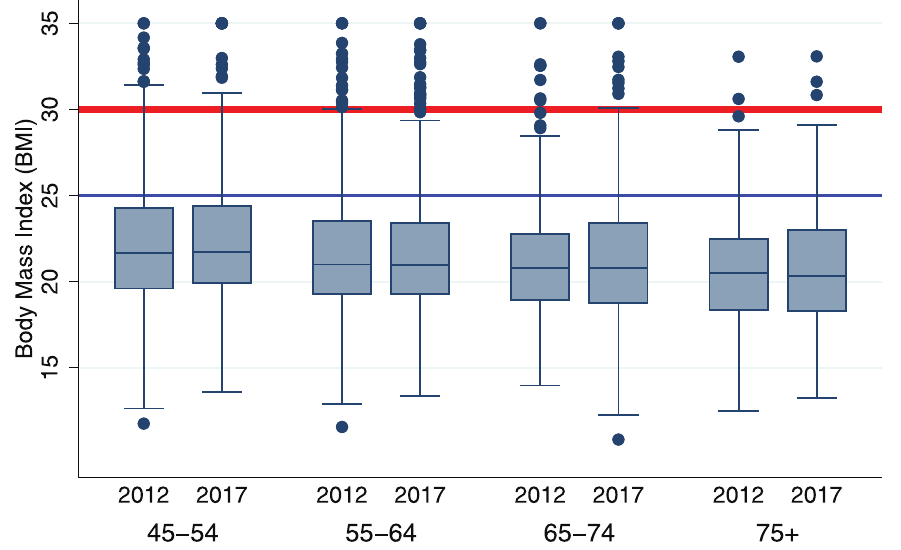
Fig 3. Body Mass Index (BMI) of MLSFH-MAC respondents aged 2012–13. Notes : Based on measured height and weight in 2012 and 2017. Red line denotes the cut-off for obesity (BMI � 30), and the blue line denotes the cut-off for overweight (25 � BMI � 30). Age group is assigned based on age in 2017. Source : Kohler et al.